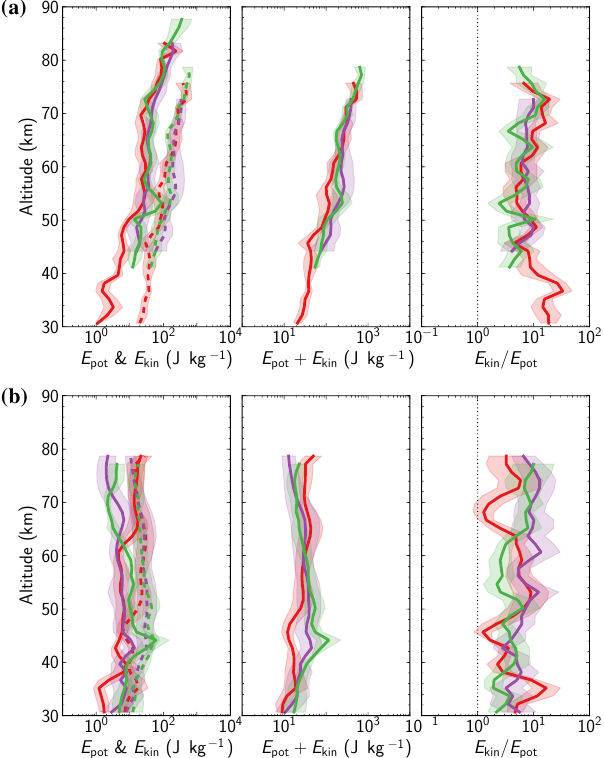
Figure 7. January mean gravity wave energy densities for 2012 (red), 2014 (purple), and 2015 (green) derived from lidar data (a) and ECMWF data (b). Shading represents the respective standard deviation. Left: potential (solid) and kinetic (dashed) GWED. Middle: total GWED. Right: kinetic-to-potential GWED.